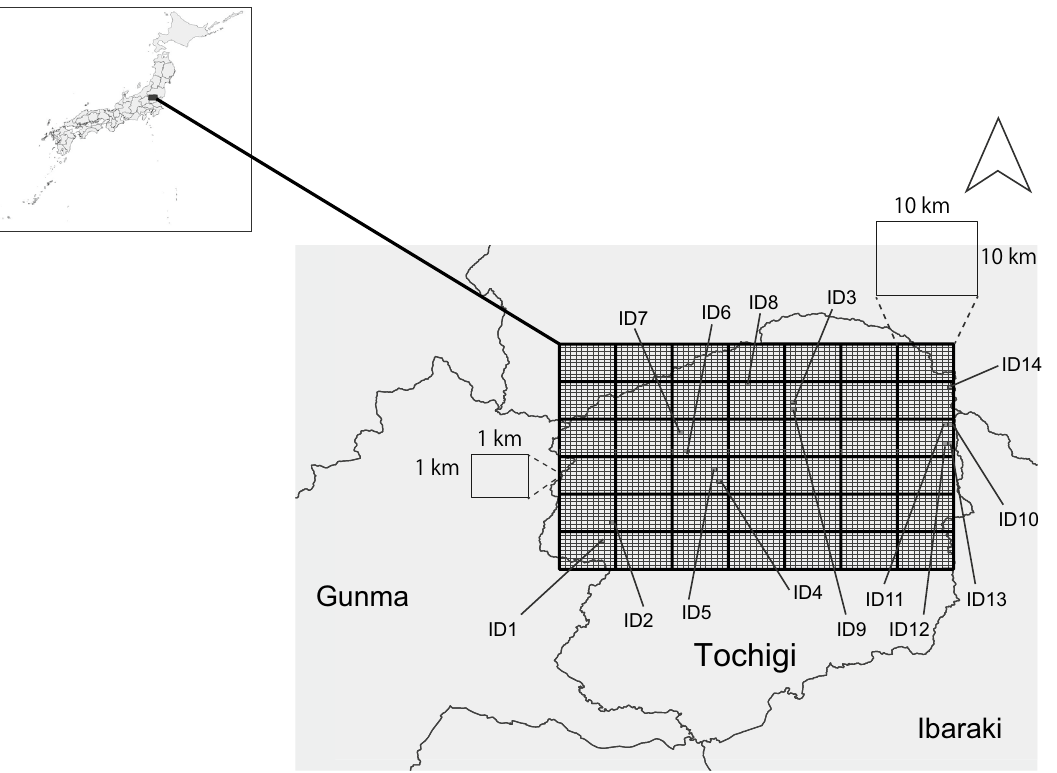
Figure 2. Study area, analytical units, and locations of the camera